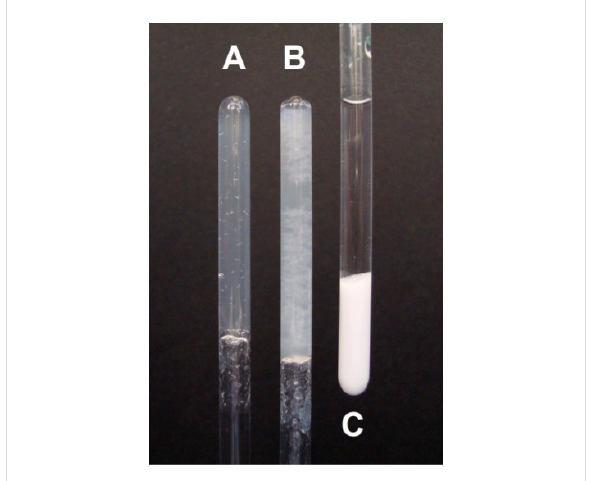
Figure 4: Precipitation of orthosilicic acid with amine 1 in NMR tubes at pH 6.5 (A), 7 (B), and 10 (C). Inefficient silicification in A and B is accompanied by gelation and high viscosity of the reaction mixture. Complete precipitation under the conditions of C shows a sharp sep- aration between the clear solution and the precipitate which is sep- arated by centrifugation to obtain a high-resolution 1 H NMR spectrum